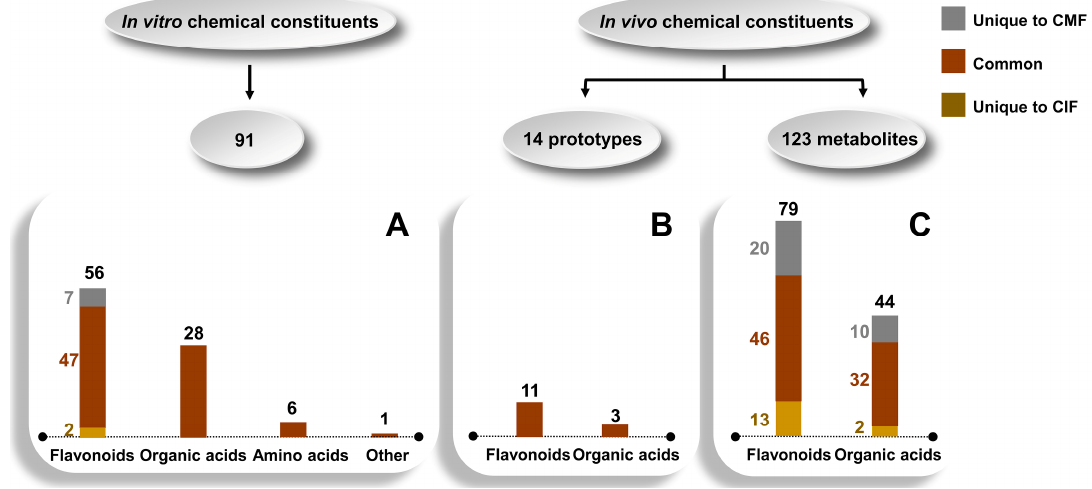
Figure 1. The composition of the in vitro and in vivo components between CMF and CIF. ( A )—In vitro chemical composition differences between CMF and CIF extracts; ( B , C )—Differences in prototype components and metabolites in rat plasma between CMF and CIF under the LFHSH pathological state.